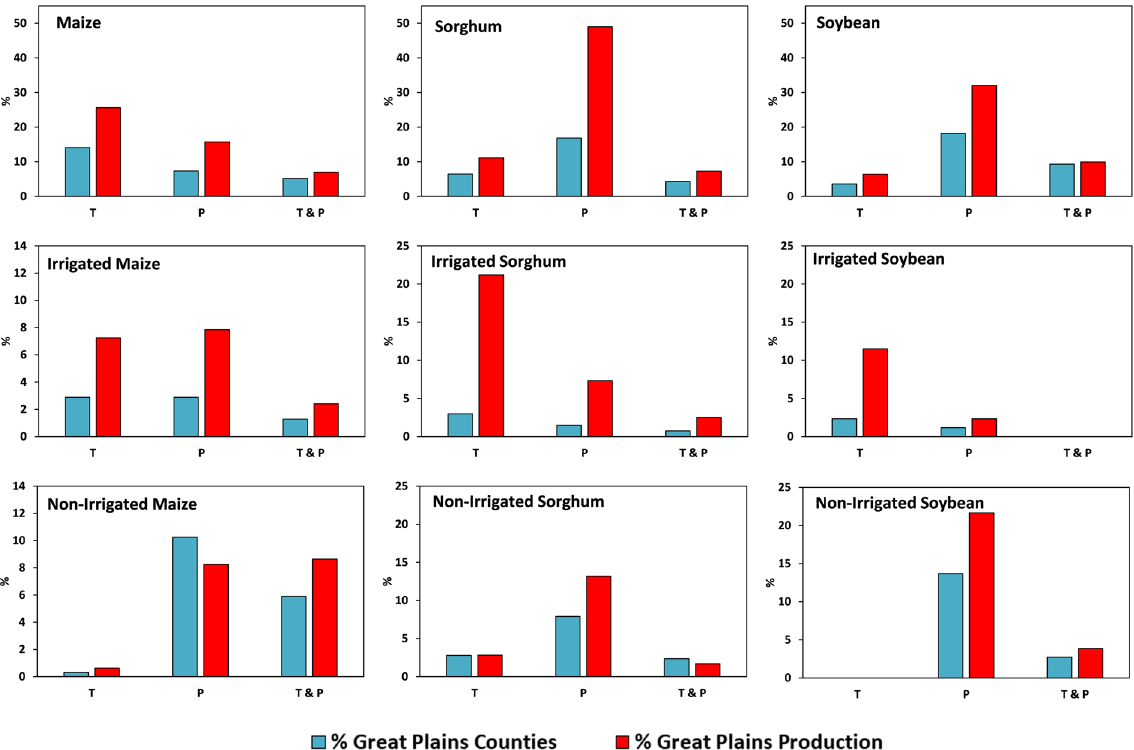
Figure 7. Proportion of Great Plains counties and crop production for maize, sorghum, soybean yields (pooled, irrigated and non-irrigated) where temperature, precipitation, or both were the dominant climate factor towards explaining crop yield variability. Blue bars indicate proportion of Great Plains counties for which a specific climate factor was dominant and red bars indicate proportion of Great Plains production for which a specific climate factor was